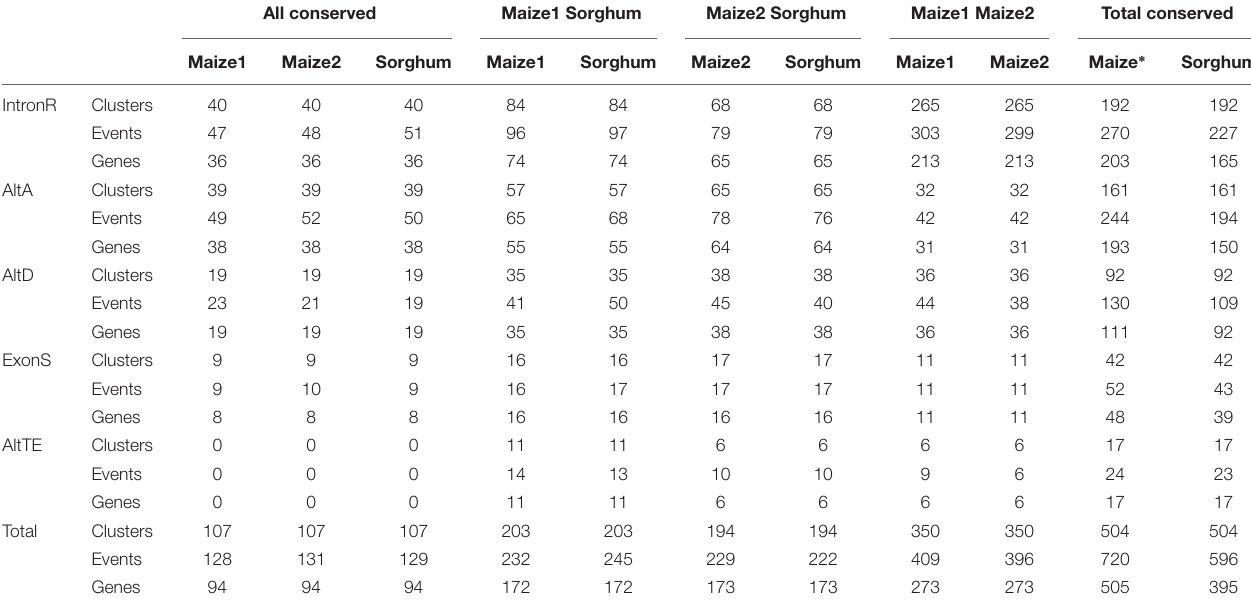
TABLE 1 | Conserved AS between maize subgenomes and